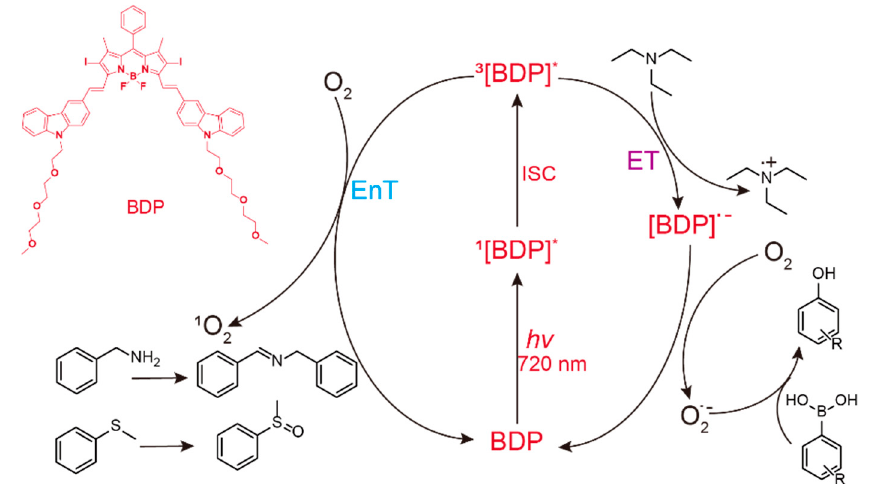
Figure 1. Mechanism of NIR-driven BDP-catalyzed photooxidation.